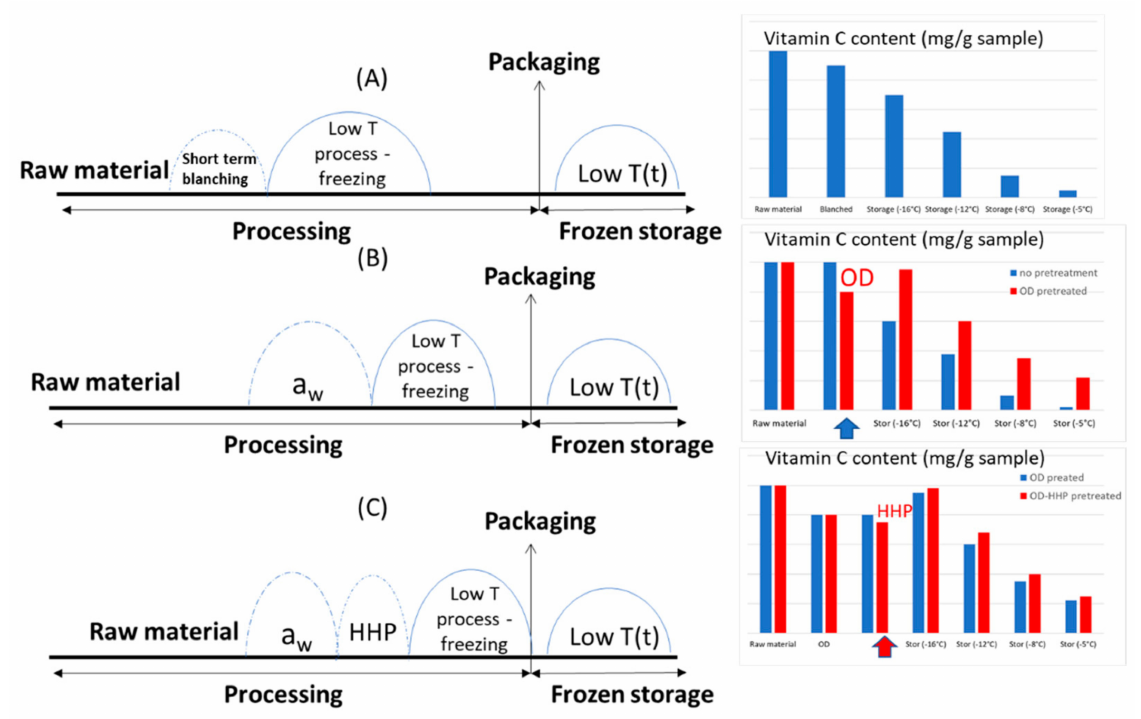
Figure 3. Indicative preservation scenarios (on the left, A – C ) for frozen strawberries, depicted as successive hurdles (where a w represents a water decrease processing step-namely, osmotic dehydration—and HHP is a high hydrostatic pressure process) and the corresponding Vitamin C content after each step (representative values based on the data published in References